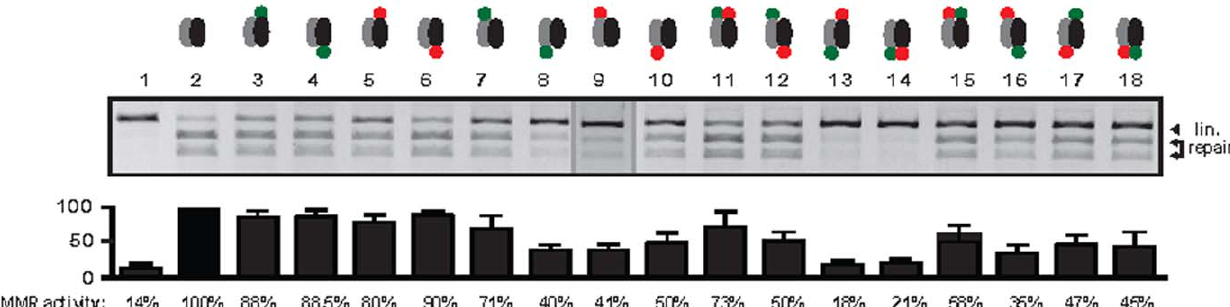
Figure 4. Influence of fluorescent tags on MMR activity of MutL a . HEK293T cells were transiently cotransfected with various labeled or unlabeld MutL a constructs and 48 h post transfection MMR activity of different MutL a s were assessed in vitro in parallel with unlabeled MutL a by quantifying the 3 9 -nick-directed correction of a G-T mismatch in a restriction site of a plasmid substrate as detailed in ‘‘Materials and Methods’’ and as previously described [10]. In vitro repair was scored on a 2-kb circular DNA substrate that contains an EcoRV site which is destroyed by a G-T mismatch. Upon repair of the G-T mismatch to an A-T base pair the intact EcoRV site together with an AseI site gives rise to a 0.8- and a 1.2-kb fragment, whereas unrepaired DNA is only linearized by AseI to a 2-kb fragment. Repair efficiency was assessed by measuring the signal intensities of linearized and digested vector with Bio-Rad Quantity One software using the ‘‘rolling ball’’ baseline correction. The signal intensity of the repair bands was divided by the intensity of all three bands. Repair efficiency of unlabeled MutL a was set at 100 percent and repair of fluorescent tagged MutL a was determined in relation to the wild-type sample that was expressed, processed and tested in parallel. Average repair values and standard deviations ( 6 ) were determined from four independent experiments. Single PMS2 tagged MutL a s, single MLH1-GFP-N tagged MutL a s as well as MLH1-GFP-N coexpressed with PMS2-Red-N or MLH1-Red-N coexpressed with PMS2-GFP-N were MMR proficient while all other tagged variants showed MMR deficiency. 1: mock control (untransfected). 2: MLH1/PMS2 unlabeled (positive control); 3: MLH1/PMS2-GFP-N; 4: MLH1/PMS2-GFP-C; 5: MLH1/PMS2-Red-N; 6: MLH1/PMS2-Red-C; 7: MLH1-GFP-N/PMS2; 8: MLH1-GFP-C/PMS2; 9: MLH1-Red-N/PMS2; 10: MLH1-Red-C/PMS2; 11: MLH1-GFP- N/PMS2-Red-N; 12: MLH1-GFP-N/PMS2-Red-C; 13: MLH1-GFP-C/PMS2-Red-N; 14: MLH1-GFP-C/PMS2-Red-C; 15: MLH1-Red-N/PMS2-GFP-N; 16: MLH1- Red-N/PMS2-GFP-C; 17: MLH1-Red-C/PMS2-GFP-N; 18: MLH1-Red-C/PMS2-GFP-C. Symbols see Figure 1.